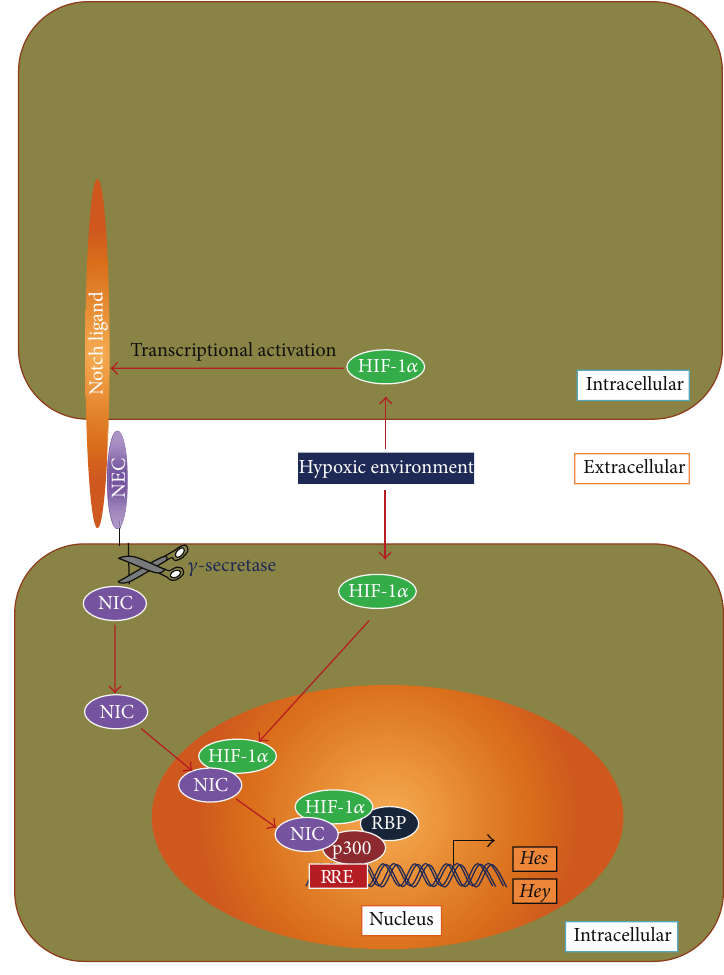
Figure 4: Crosstalk between hypoxia and notch signaling, and regulation of stem cell proliferative gene expression. HIF: hypoxia-inducible factor; NEC: notch extracellular domain; NIC: notch intracellular domain; RBP: recombination-signal binding protein. (Modified from Gustafsson et al., (2005) [34] and Sainson and Harris (2006) [136]; see text for